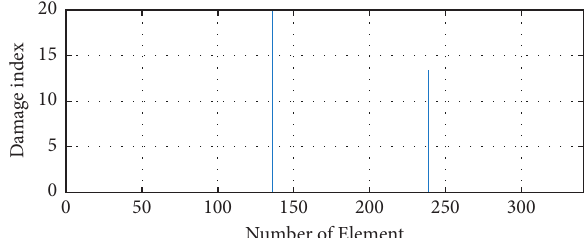
Figure 9: Results of D3 using MCA-DI (L-shape building).